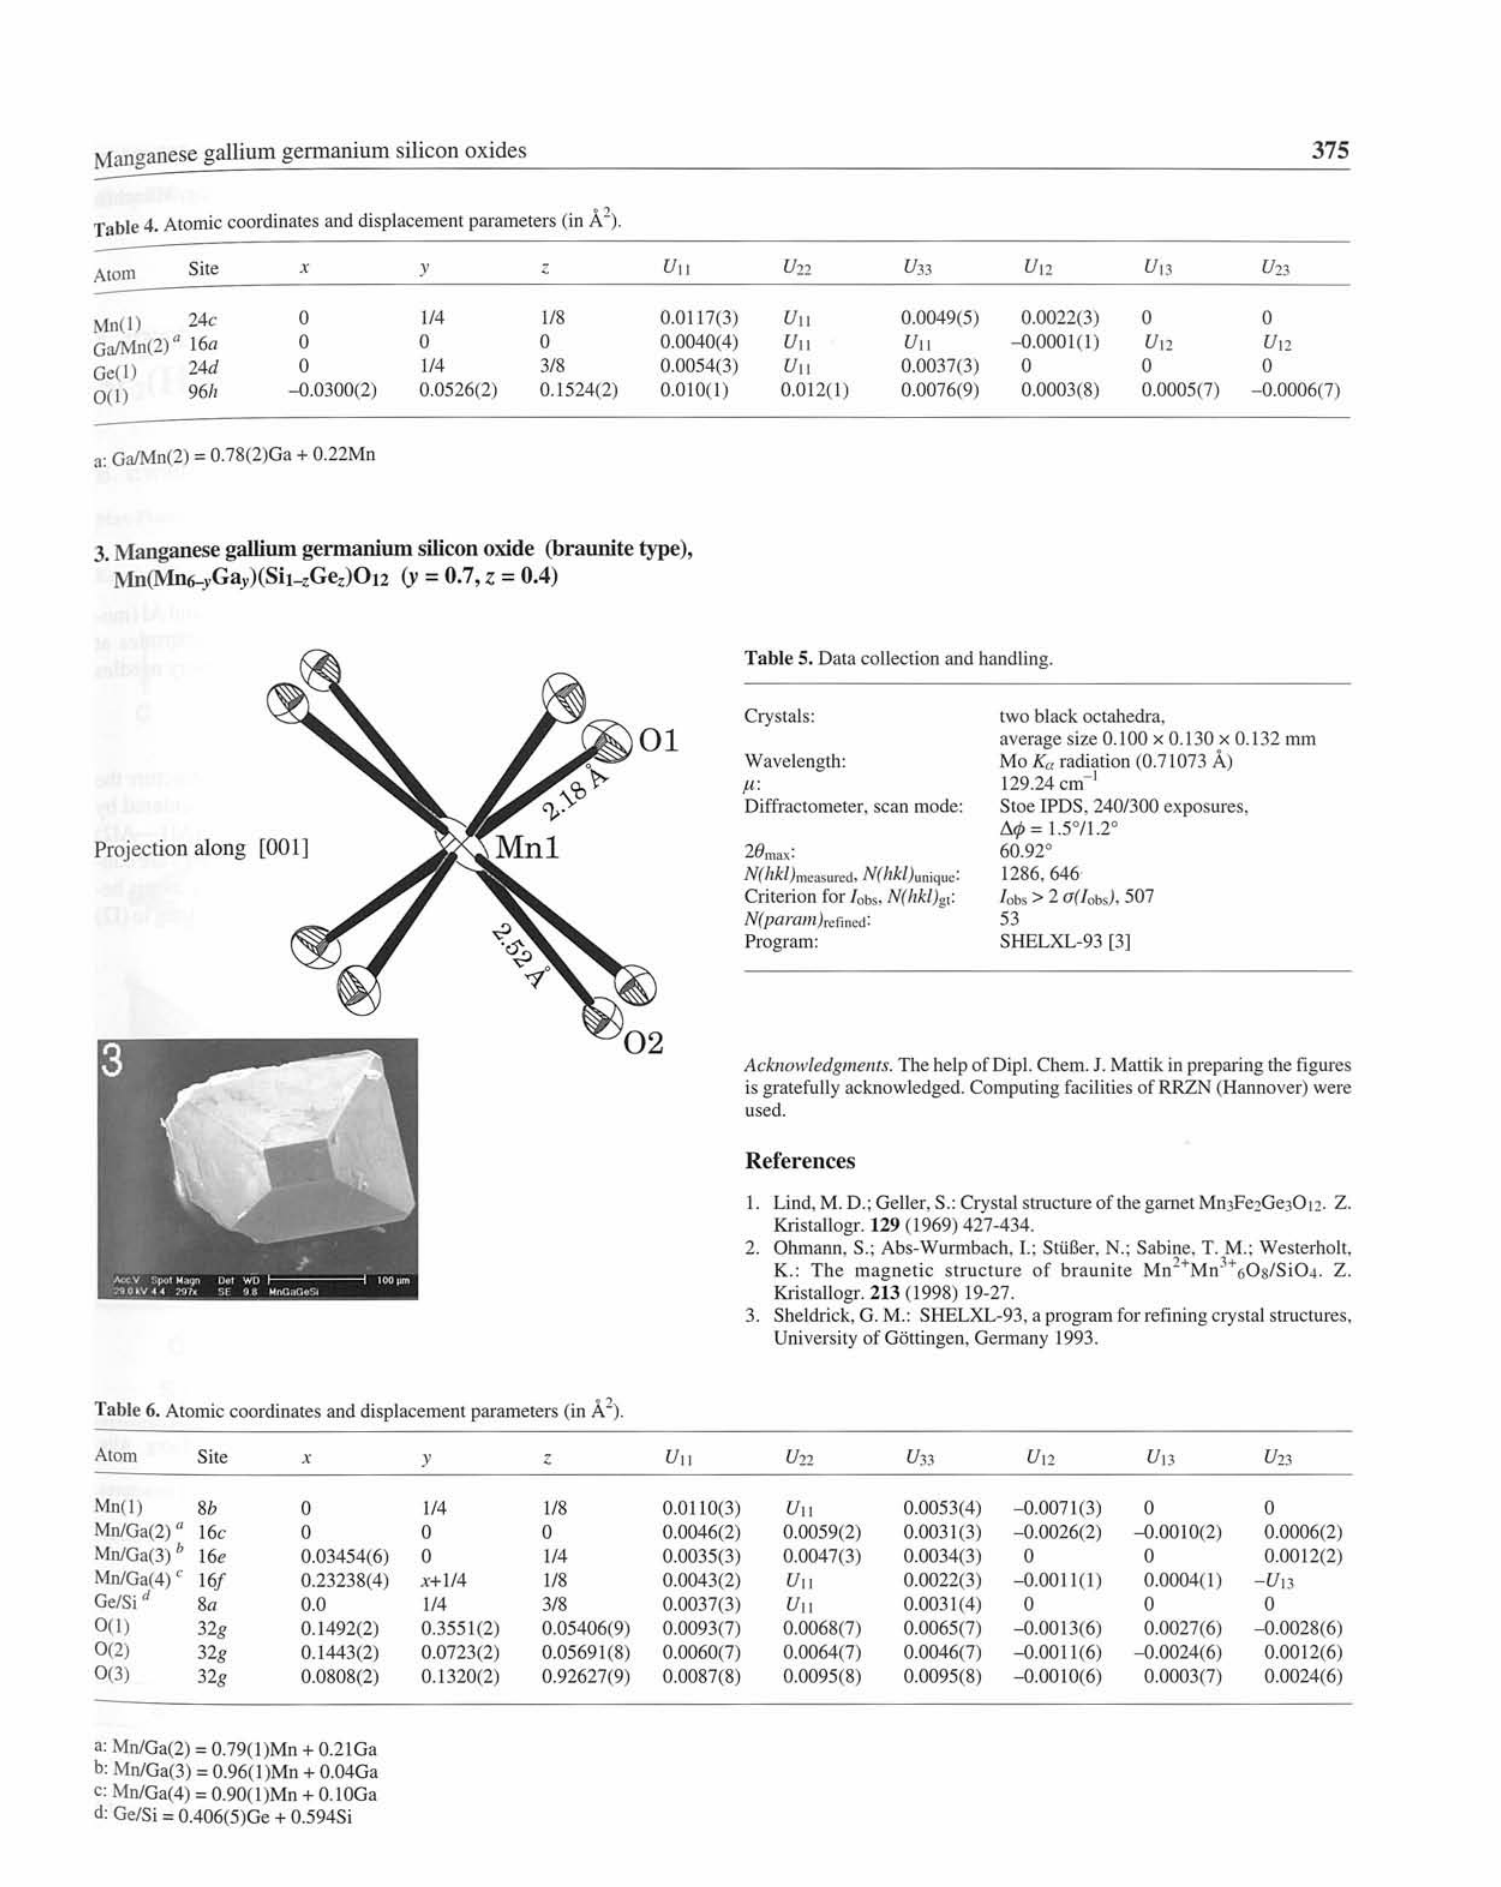
Table 6. Atomic coordinates and displacement parameters (in Â"").